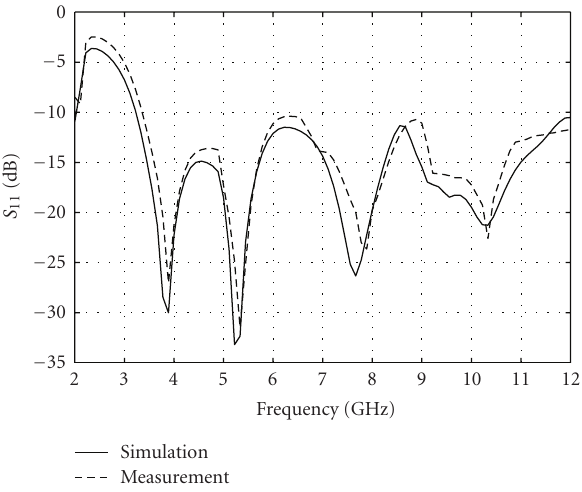
Figure 4: Measured and simulated return loss of proposed